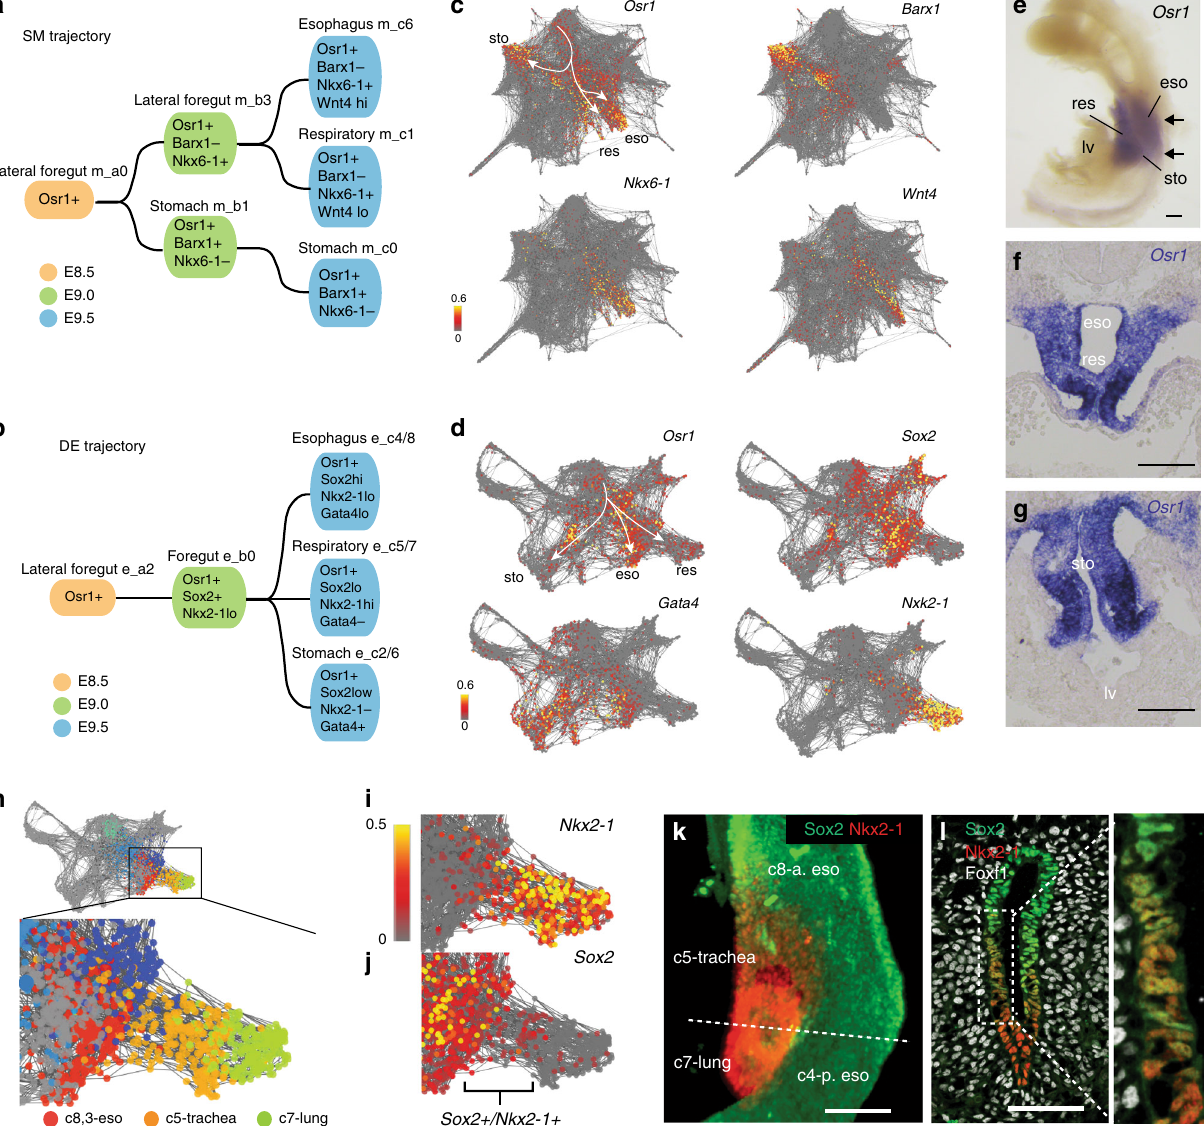
Fig. 4 Coordinated development of endoderm and mesoderm progenitor populations. a , b Graphical illustration of the esophageal – respiratory – gastric cell-state trajectories for a SM and b DE with key marker genes. This suggests the coordinated development of Osr1 + multi-lineage progenitors. c , d SRPING plots of c SM and d DE projecting the normalized expression of key genes in each cell. e In situ hybridization of Osr1 in dissected foregut, showing Osr1 is expressed in the respiratory, esophageal and gastric regions. Scale bar: 100 μ m. n = 3/3 embryos . f , g In situ hybridization of Osr1 in sections across the respiratory and gastric regions within the foregut, showing that Osr1 is expressed in both the endodermal and mesenchymal cells. Scale bar: 200 μ m. n = 3/3 embryos. h SPRING plot of the DE esophageal – respiratory lineages. i , j Normalized Nkx2-1 ( i ) and Sox2 ( j ) transcript levels in each cell projected onto the SPRING plot, showing co-expression at the esophageal – tracheal boundary. k Sox2 and Nkx2-1 whole-mount immunostaining of a E9.5 mouse foregut. Scale bar: 50 μ m. n = 3/3 embryos . l Sox2, Nkx2-1, and Foxf1 immunostaining of a transverse E9.5 foregut section, con fi rming a rare population of Sox2/Nkx2-1 co-expressing cells. Panel to the right is a magni fi cation of box in ( l ). Scale bar: 50 μ m. n = 3/3